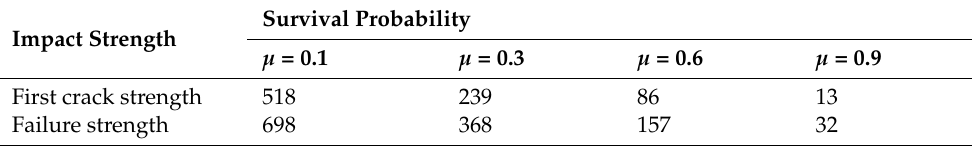
Table 5. Impact resistance of PUPC under different survival